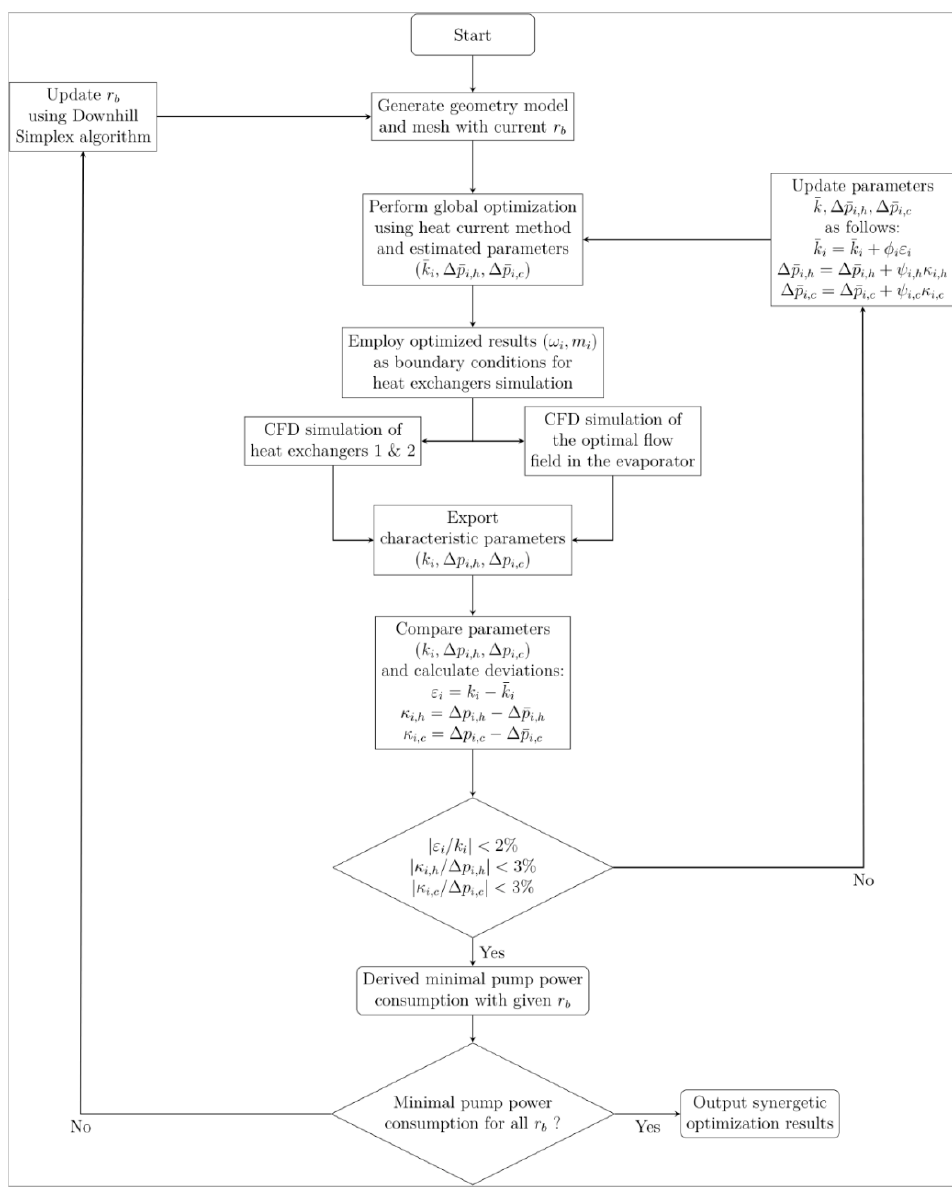
Figure 7. Flowchart of the synergetic optimization procedure.